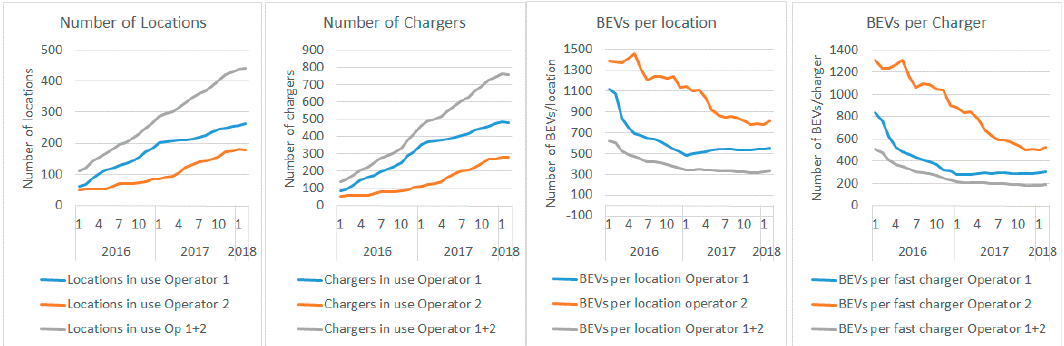
Figure 5. Number of locations and fast chargers in use per month for operator 1 and 2, and number of BEVs in the vehicle fleet per location and per fast charger. Sources: Dataset 1, dataset 2, dataset 4.